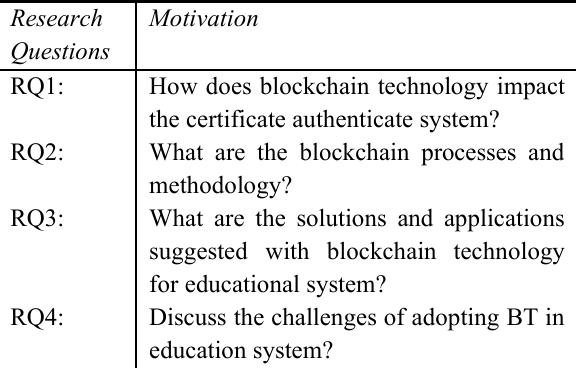
Table 1. Research Questions and motivation